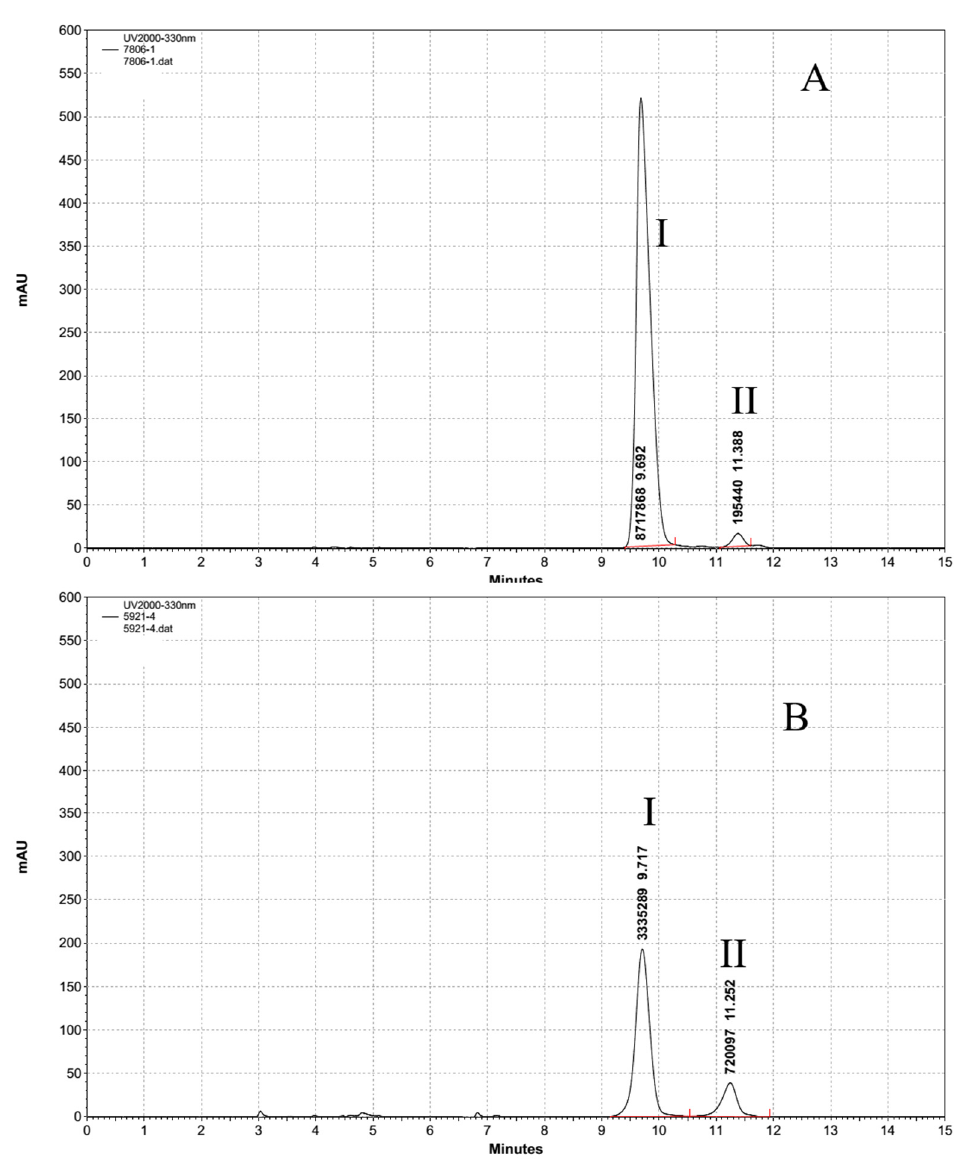
Figure 4. HPLC chromatography analysis of the purified MAAs of two strains. Both M aeruginosa PCC7806 ( A ) and Aph. flos-aquae CHAB5921 ( B ) extraction showed the same two characteristic peaks at 9.7 min and 11.3 min. I: shinorine content, II: porphyra-334 content.